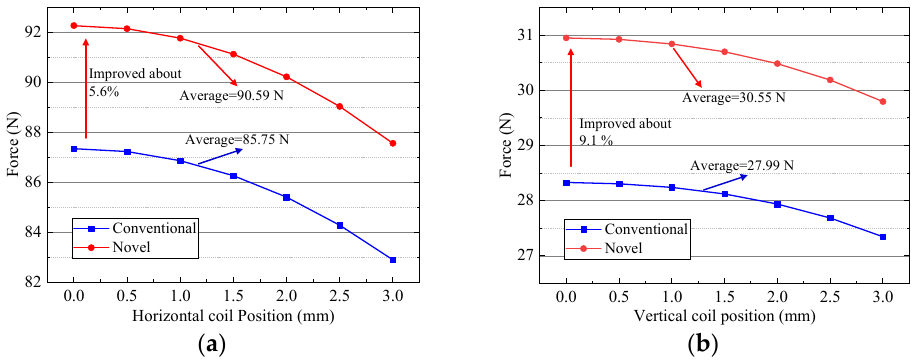
Figure 15. Driving force versus position in x direction: ( a ) Horizontal coil; ( b ) Vertical coil.